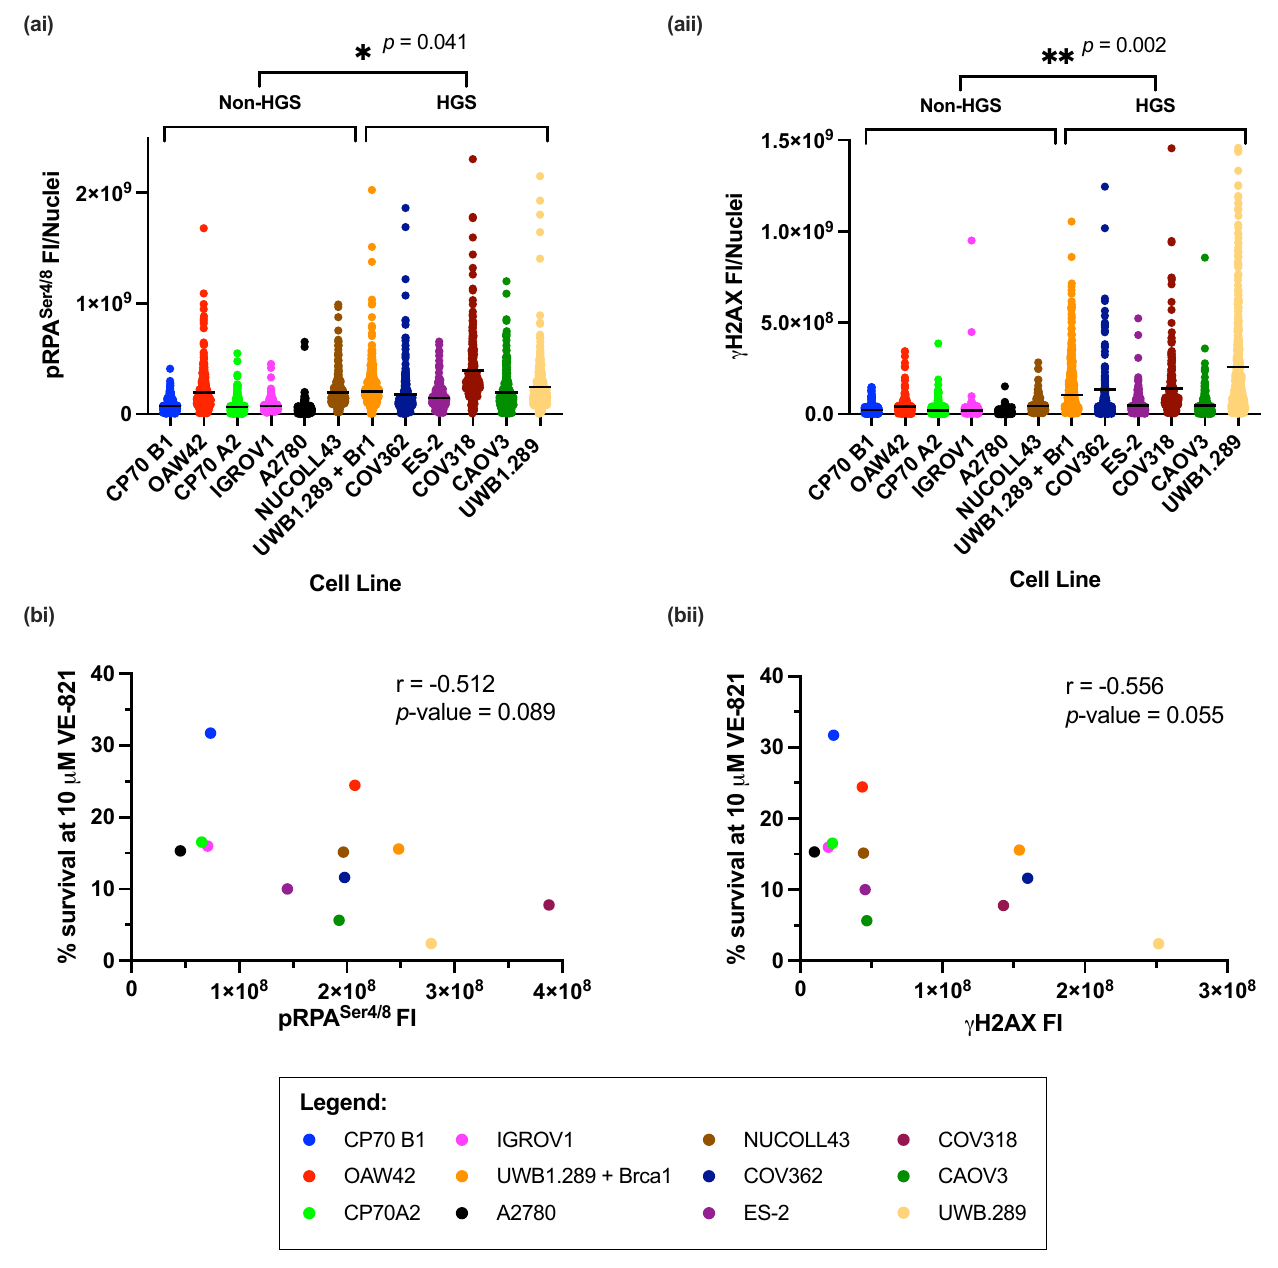
Figure 3. Measurement of intrinsic replication stress in the panel of ovarian cancer cell lines. ( a ) The fluorescence intensity of ( i ) pRPA Ser4/8 and ( ii ) γ H2AX Ser139 from 3 independent experi- ments. Horizontal black line indicates the mean FI of either ( i ) pRPA or ( ii ) γ H2AX Ser139 in each cell line. At least 80 nuclei were analyzed in each cell line in each experiment. Statistical significance between HGS and non-HGS cell lines * p < 0.05; ** p < 0.01 (Mann–Whitney test) is indicated on the graph. ( b ) Pearson’s rank correlation between; mean percentage cell survival at 10 µ M VE-821 and mean ( i ) pRPA Ser4/8 and ( ii ) γ H2AX Ser139